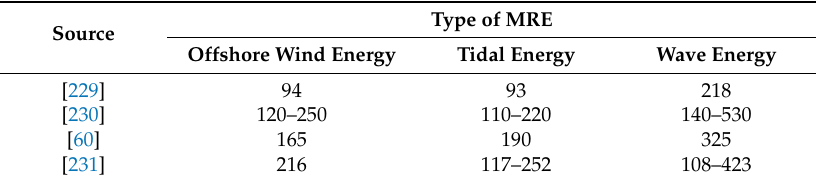
Table 2. Values of LCOE for different types of MRE ( €